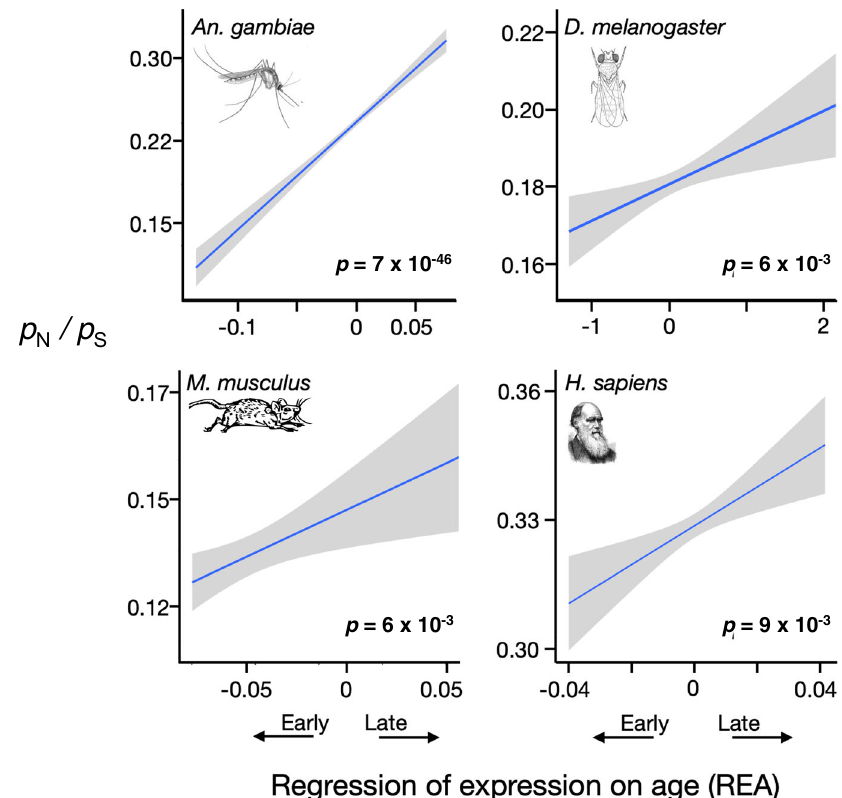
Fig. 2 Late genes are more polymorphic for nonsynonymous mutations. Genes that are more highly expressed late in life are signi fi cantly more polymorphic for nonsynonymous mutations than are genes expressed early in all four species. Nonsynonymous polymorphism is measured here as the fraction of sites in a gene that segregate for nonsynonymous alleles ( p N ) relative to the fraction segregating for synonymous alleles ( p S ). Signi fi cance was determined by Spearman rank correlations, and p -values in bold are signi fi cant at p < 0.05 (two-sided tests, not corrected for multiple tests). The lines are least squares regressions, and the gray regions show the approximate 95% con fi dence intervals for the regressions. See also Supplementary Fig. 2 and Supplementary Table